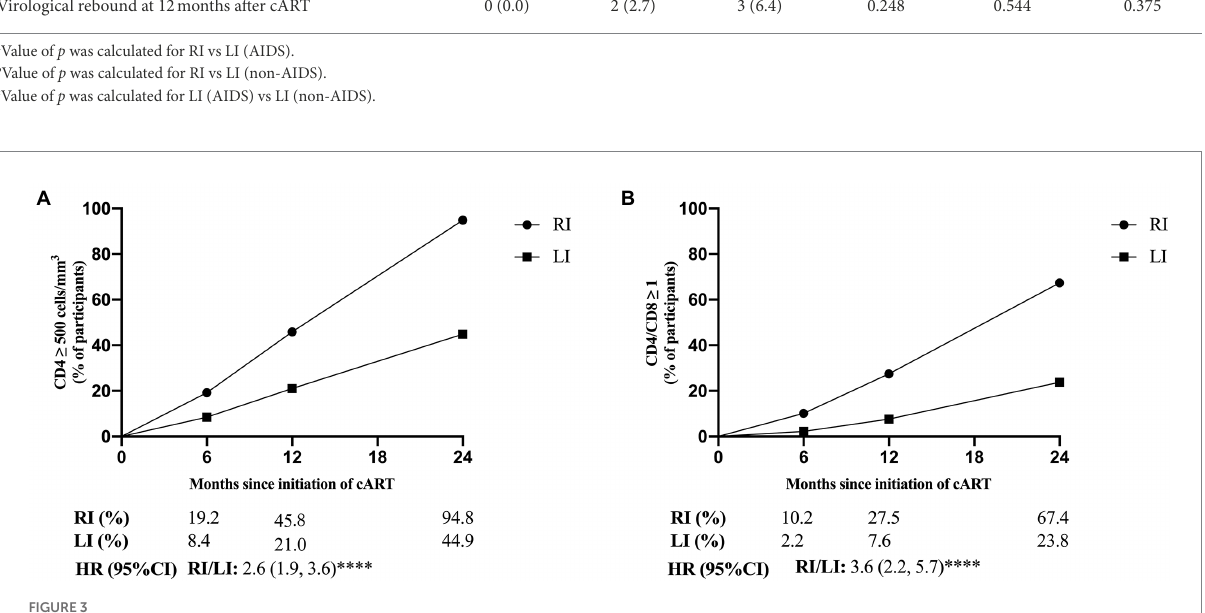
respectively (Supplementary Figure S5A) whereas the corresponding CD4/CD8 ratio recovery speed was 0.042, 0.028 and 0.018 per month,